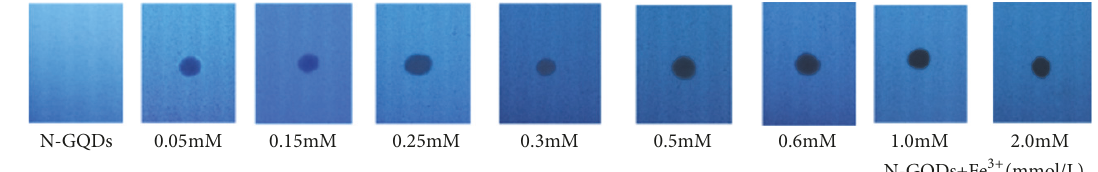
Figure 8: Titration of 0-2.0 mmol/L Ferric Ions in N-GQDs solutions (the concentration range of iron ions is 0-2.0mmol/L).